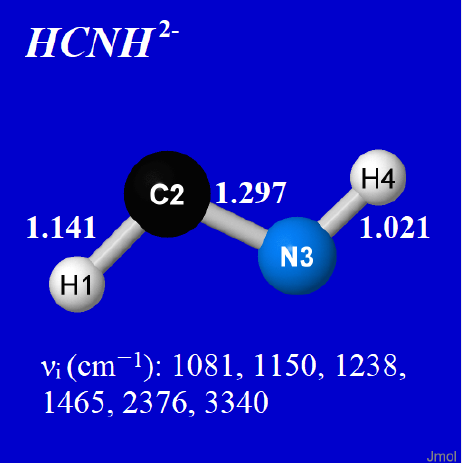
Figure 7. Optimized structure of model HCN 2 − ···H complex, showing bond lengths (Å) and har- monic vibration frequencies (cm − 1 ) of the equilibrium B3LYP/6-311++G** species.